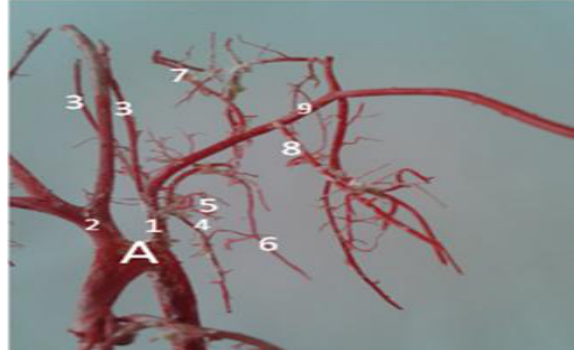
Figure, 5: The cast of the aortic arch in rabbits (left lateral view) showing, (A)aortic arch (1) Left subclavian artery (2) Brachiocephalic trunk (3) Vertebral arteries (4) Costocervical artery (5) Cervical profund artery (6) Internal thoracic artery (7) superficial thoracic artery (8) External thoracic artery (9) Axillary